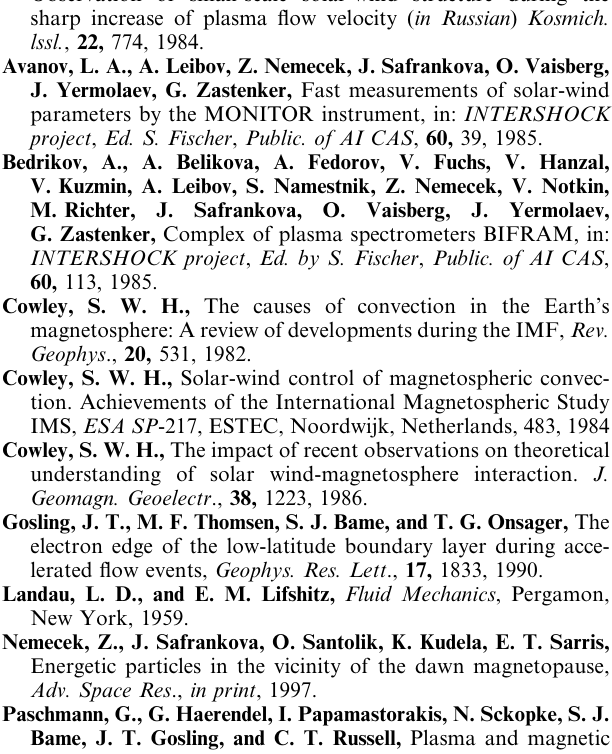
Fig. 1, or by flux ropes which connect the reconnection site at the magnetopause with the magnetosphere.